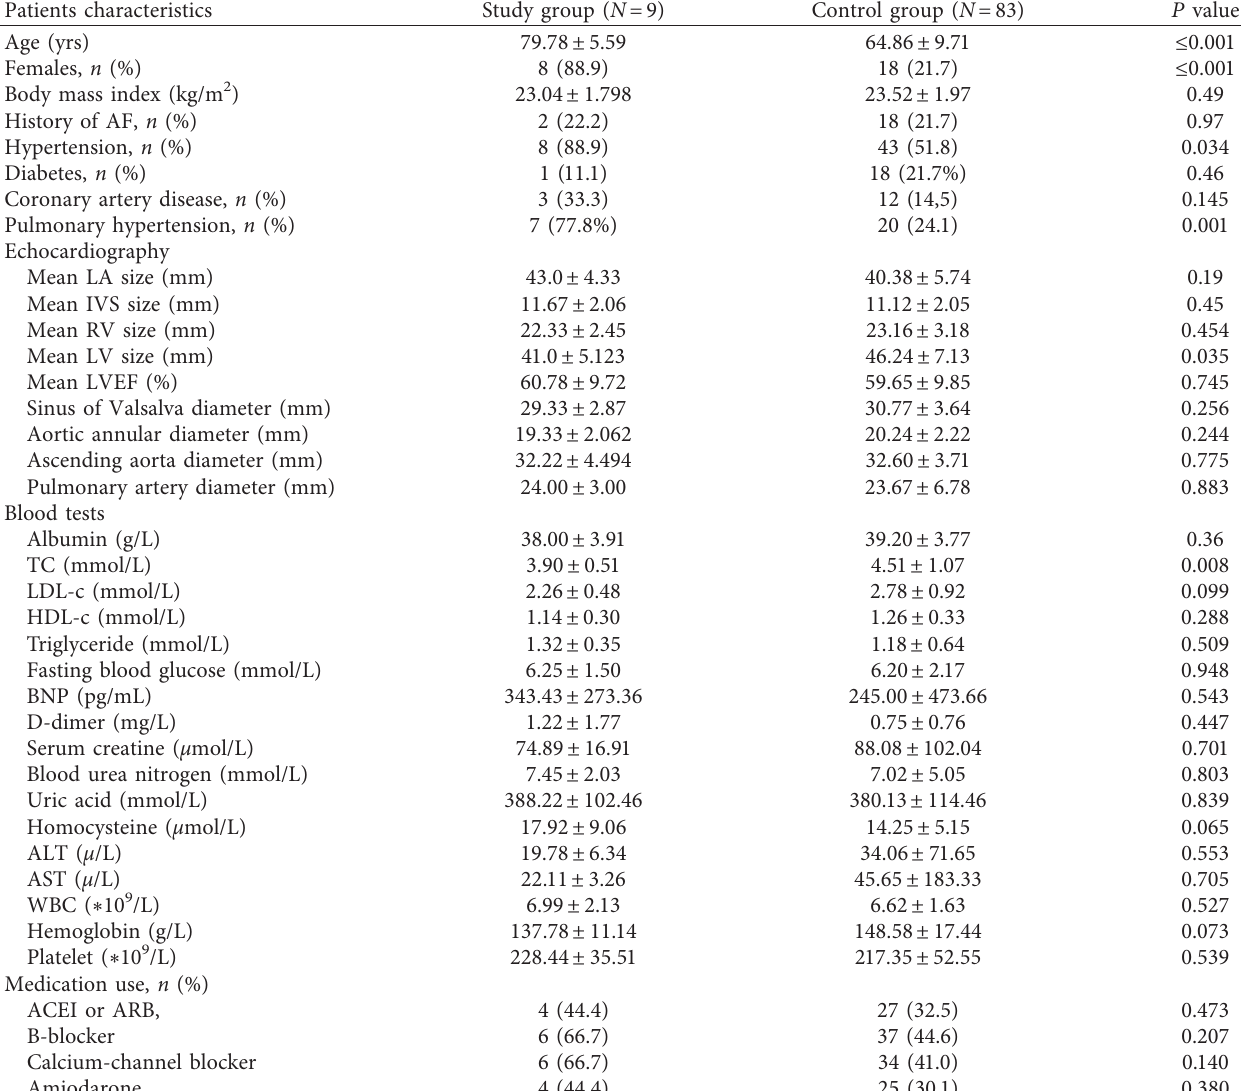
Table 4: Patient characteristics.